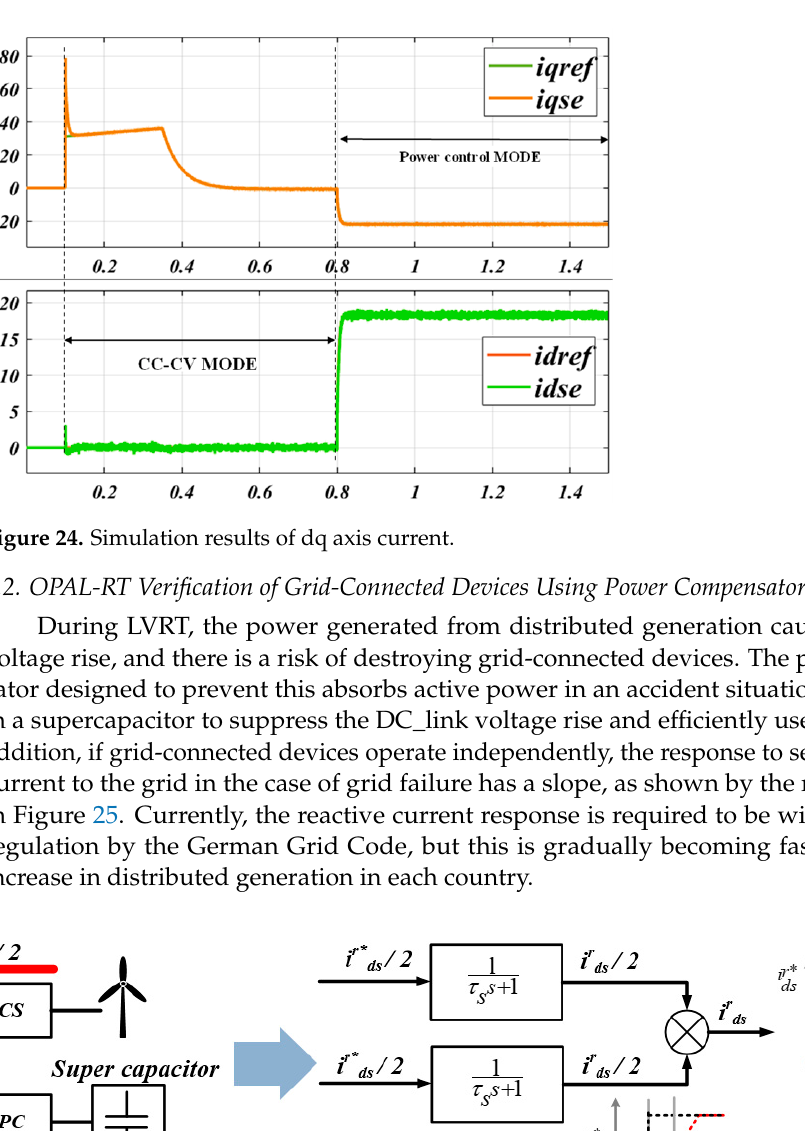
Figure 23. Simulation results of active/reactive power.